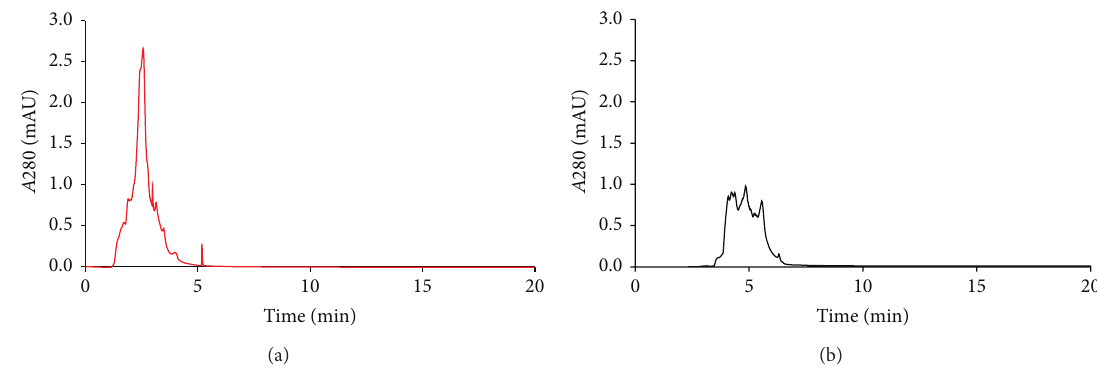
Figure 1: HPLC profiles of the E. coli protein-bound compounds from (a) Sanjin Tablets and (b) water control. HPLC column: C18. Mobile phase: 100% acetonitrile. Flow rate: 1mL/min. UV wavelength: 300 nm.